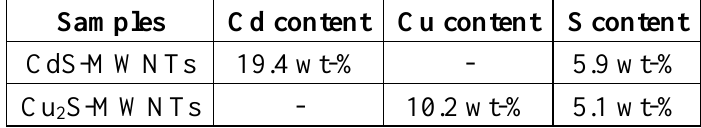
S-MWNT prepared by 2